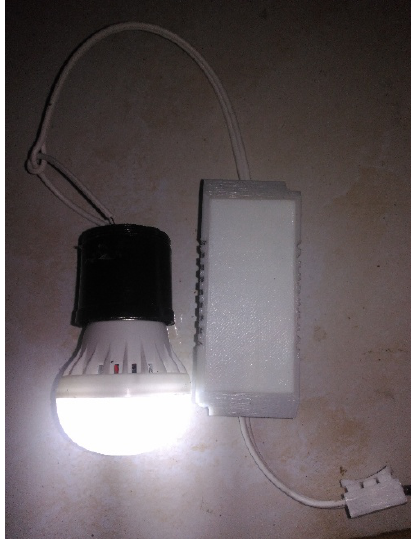
Figure 7. Smart panel receiver when controlling loads in the ON condition